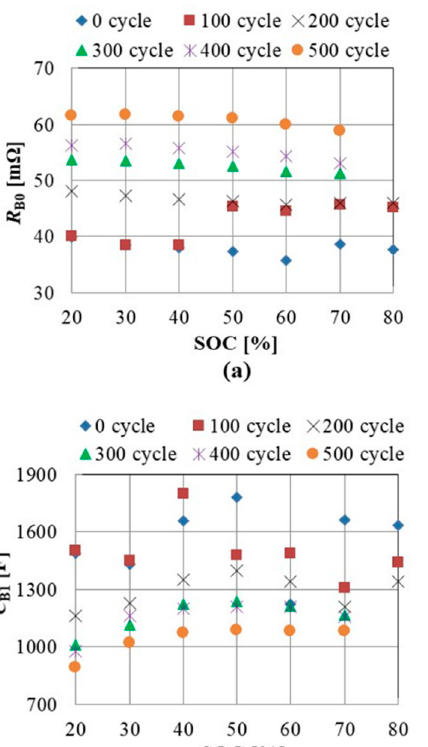
Figure 7. Effect of SOC. ( a ) Voltage. ( b ) Integrated voltage.